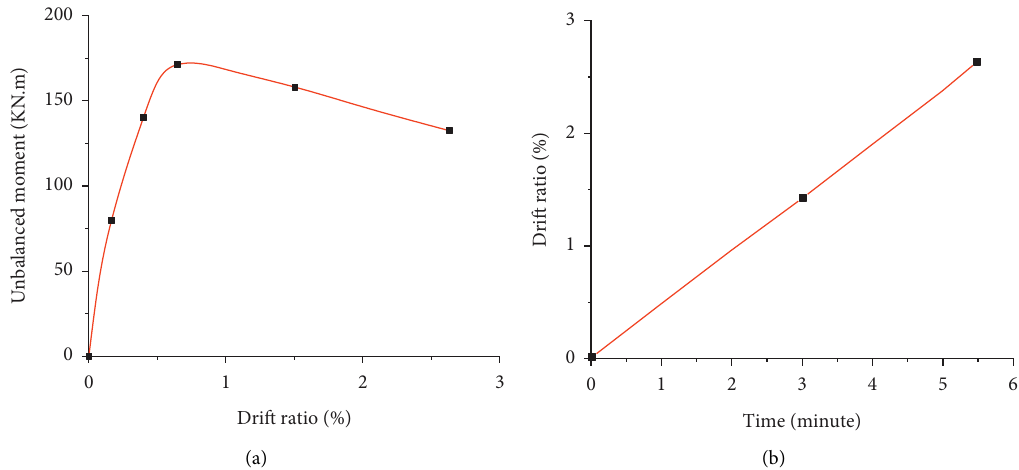
Figure 28: (a) Unbalanced moment drift ratio response and (b) drift ratio-fre exposed duration response of 20% axial load level.